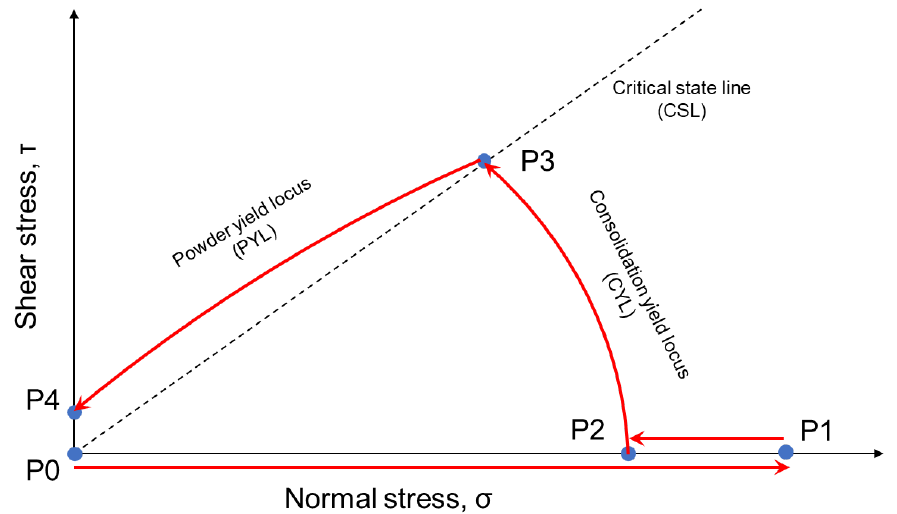
Figure 2. Shear test procedure for powder beds using a Nanoseeds constant-volume-type shear tester (NS-S500) (the procedure is based on Tsunakawa et al. [23] ).